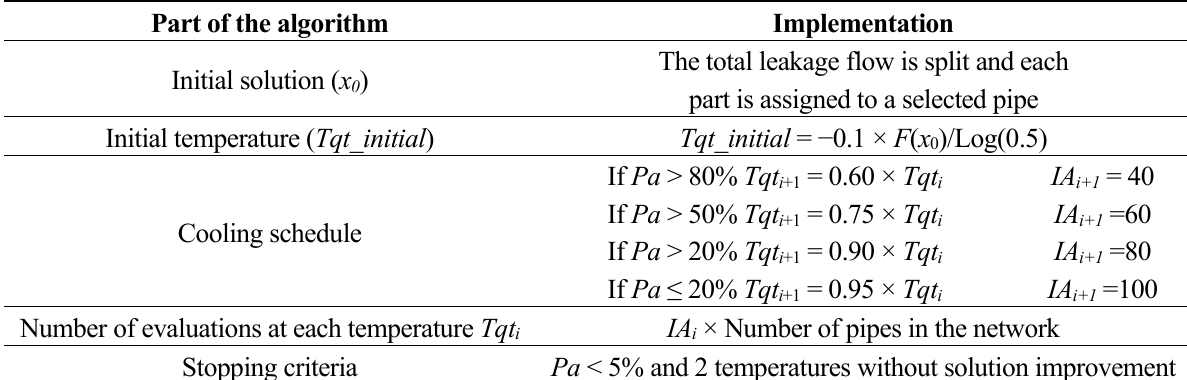
Table 1. Simulated annealing algorithm